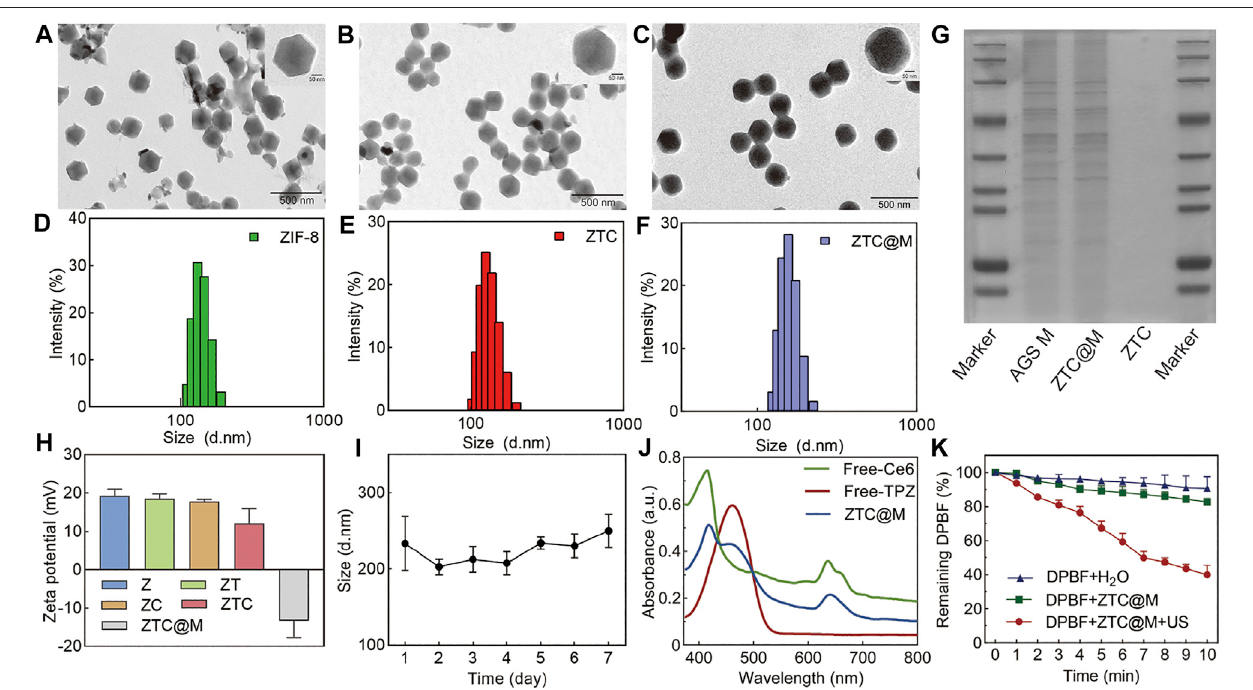
FIGURE 2 | Characterization of ZTC@M nanoparticles. TEM and magni fi cation images of ZIF-8 (A) , ZTC (B) , and ZTC@M (C) . The scale bar is 200 nm. Hydrated nanoparticlesizedistributionofZIF-8 (D) ,ZTC (E) ,andZTC@M (F) .Gelelectrophoresis ofAGScytomembraneandZTC@M (G) .Zetapotentialofdifferentnanoparticles (H) . The change of hydrated nanoparticle size of ZTC@M (I) . The ultraviolet-visible absorption spectra of free-Ce6, free-TPZ, and ZTC@M (J) . Reactive oxygen species (ROS) production by ZTC@M under different conditions (K) .